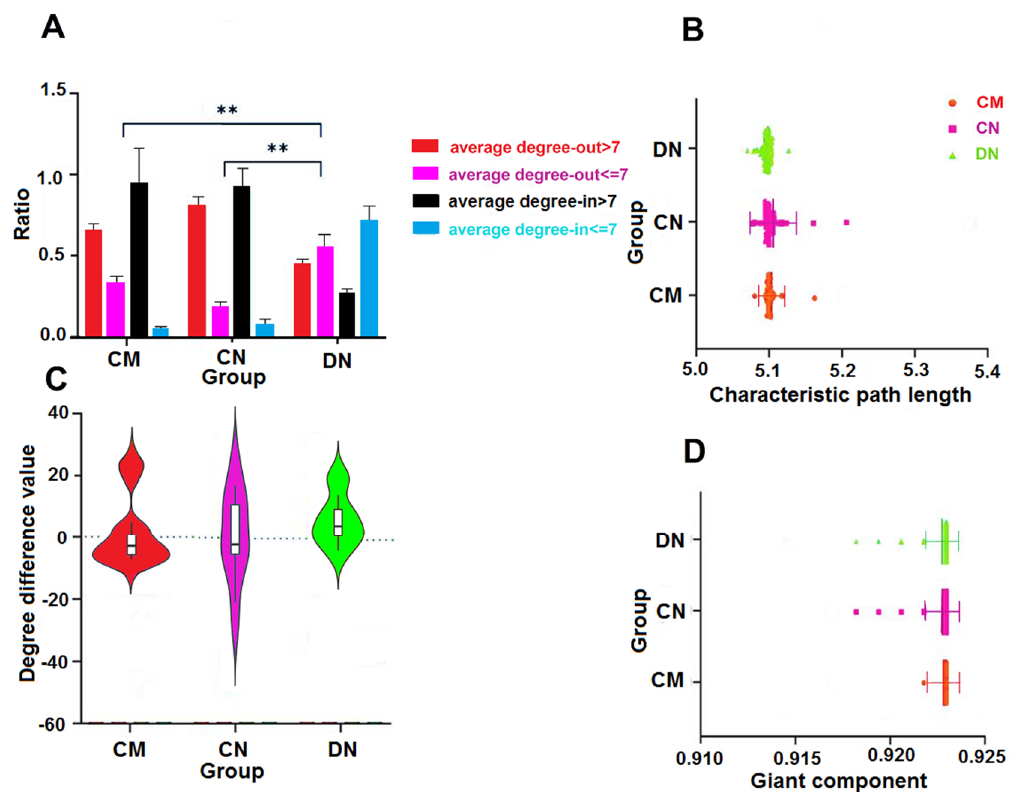
Figure 2. Network analysis of CM (core module), CN (core nodes), and DN (driver nodes): ( A ) the distribution probability of 4 levels of the HNS; ( B ) comparison of the changes in the characteristic path length after the nodes in CM, CN, and DN are deleted; ( C ) comparison of the degree difference values in CM, CN, and DN; ( D ) comparison of the changes in the giant component after the nodes in CM, CN, and DN are deleted. All data are represented as the mean ± SEM. ** p < 0.05.